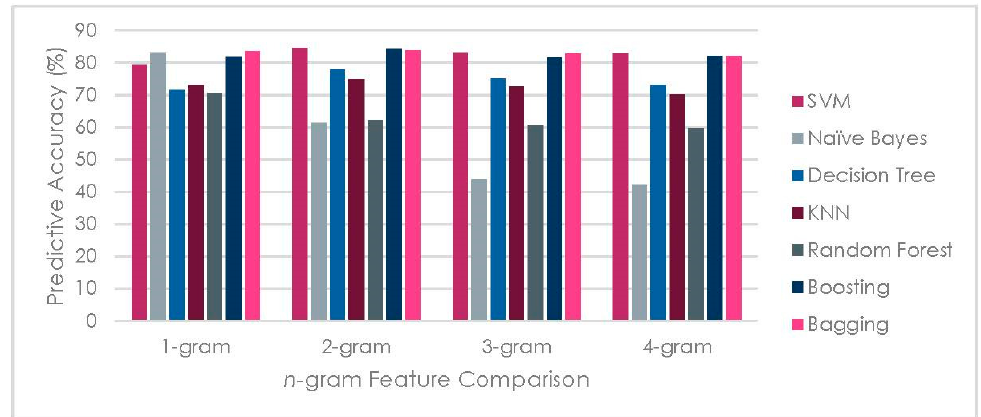
Figure 6. n -Gram impact on classification model accuracy.